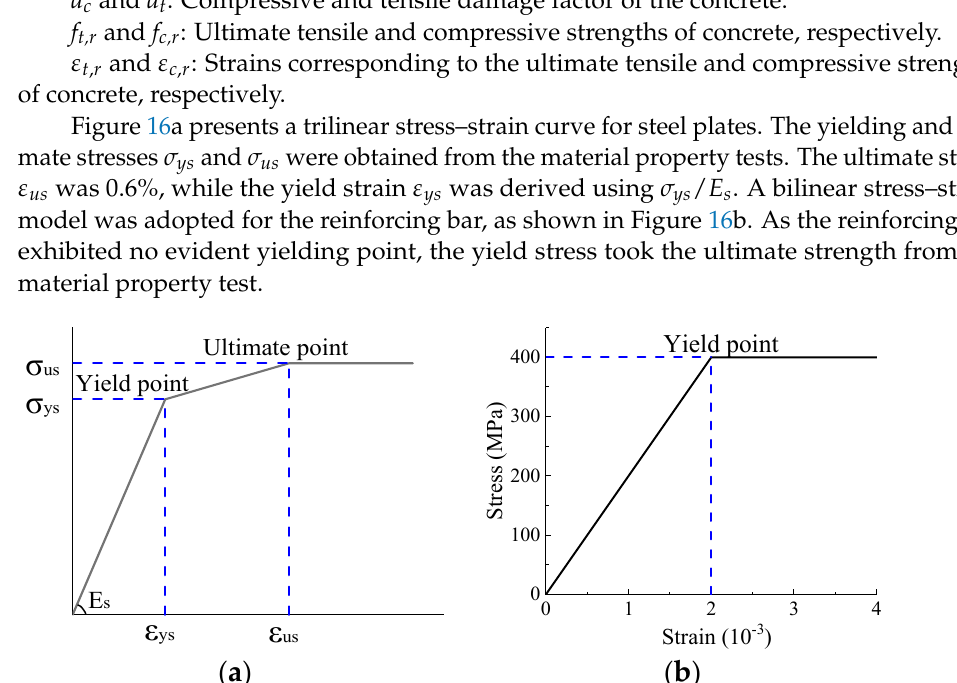
Figure 17. The two curves matched well with each other. The phenomenon of interlayer slip around 150 kN appeared in the theoretical curve, which is consistent with the experimental observation and the strain analysis. The initial bending stiffness (at 100 kN) and the load- carrying capacity of the FEM model were 72.4 kN/mm and 1009.6 kN, respectively, which were slightly larger compared to the test specimen. The deviation could be attributed to the accuracy of the material constitutive laws as well as to the simulation of the steel–concrete interlayer